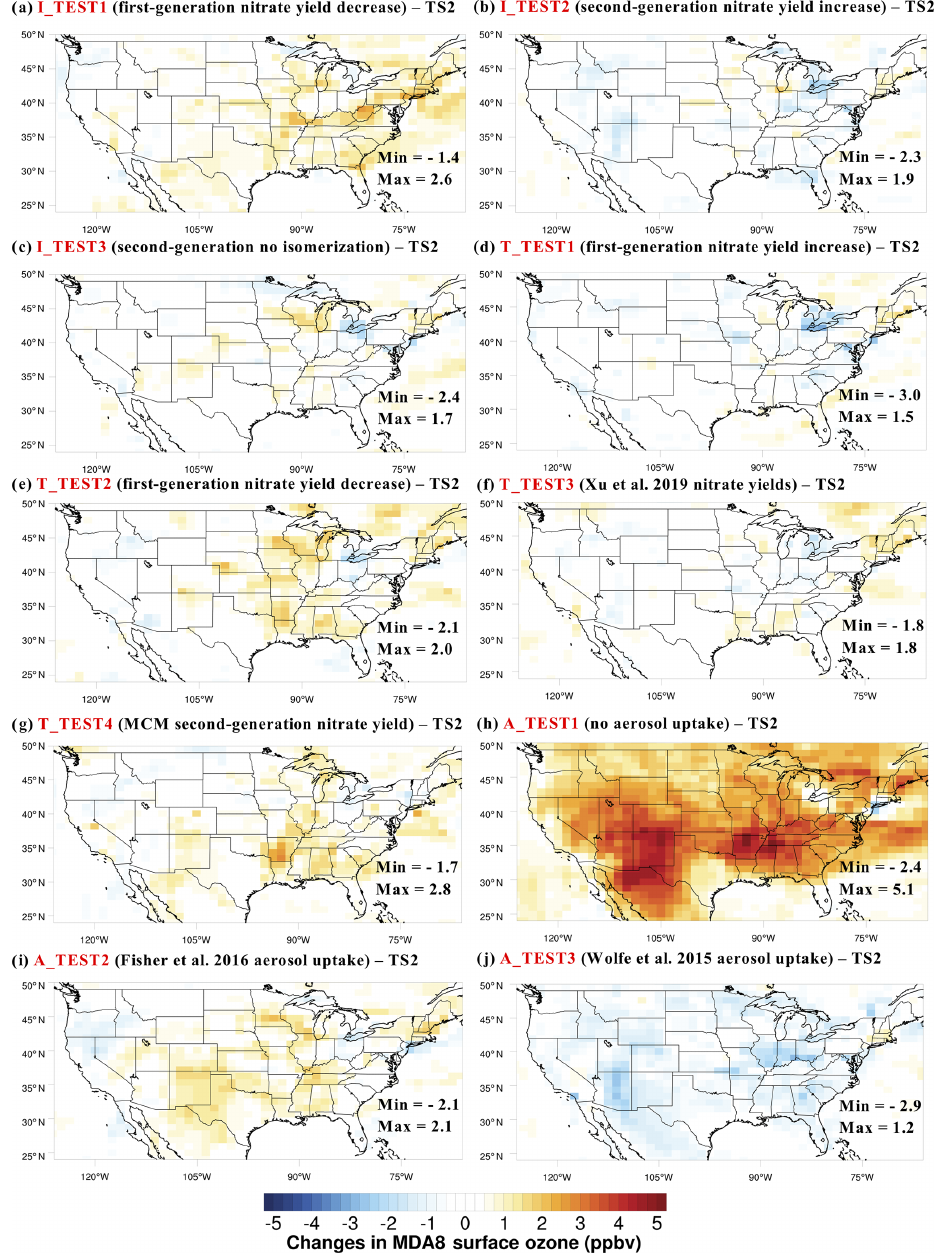
Table 1 and the TS2 case. For each case, the minimum and maximum over the domain pictured is displayed on the bottom